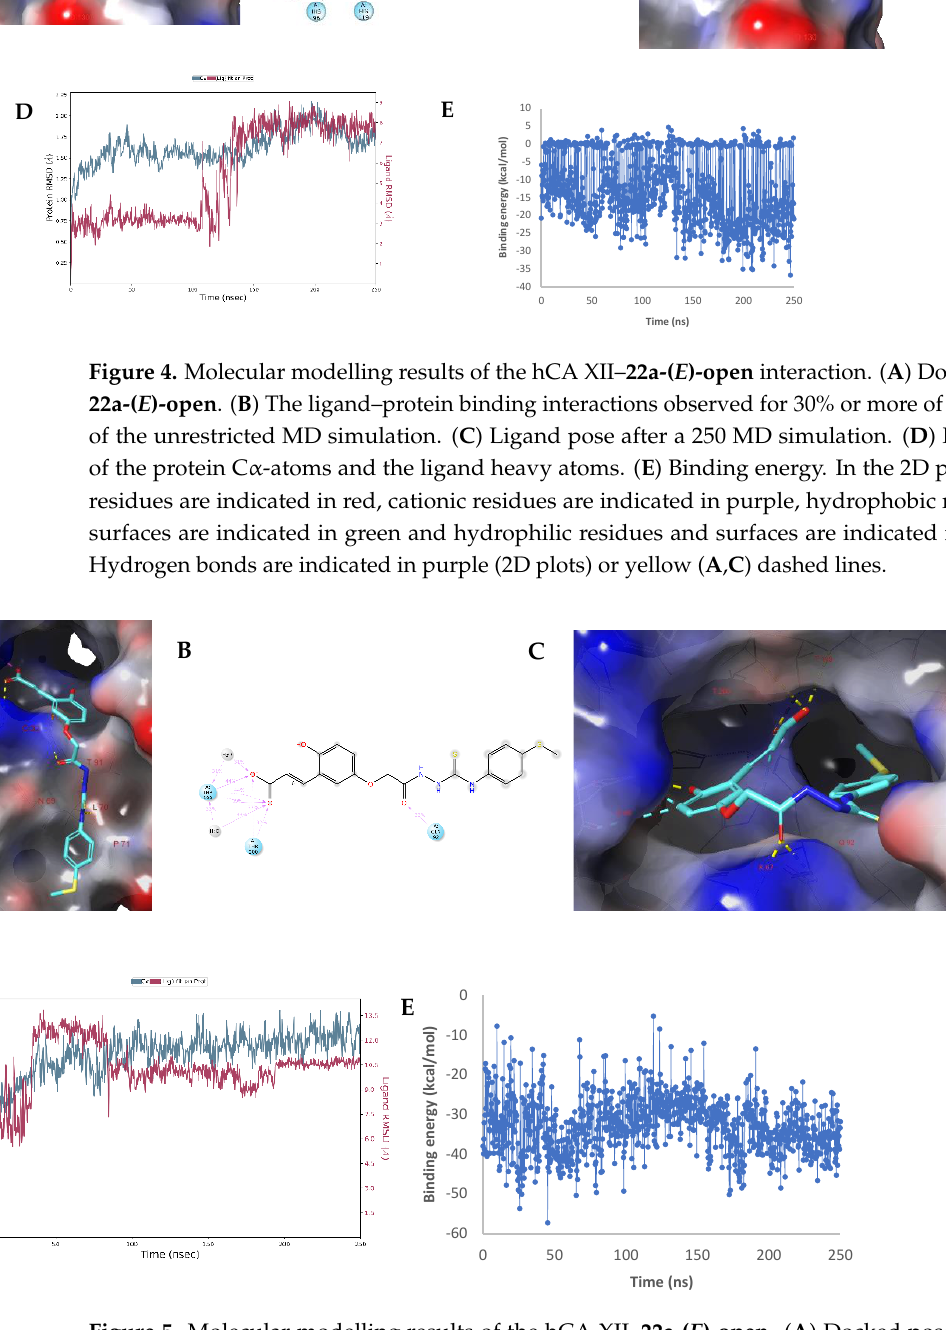
Figure 5. Molecular modelling results of the hCA XII– 22a-( E )-open . ( A ) Docked pose compound 22a-( E )-open . ( B ) Ligand–protein binding interactions observed for 30% or more of the duration of the unrestricted MD simulation. ( C ) Ligand pose after a 250 MD simulation. ( D ) RMSD value of the protein Cα -atoms and the ligand heavy atoms. ( E ) Binding energy. In the 2D plots, anionic residues are indicated in red, cationic residues are indicated in purple, hydrophobic residues and surfaces are indicated in green and hydrophilic residues and surfaces are indicated in light blue. Hydrogen bonds are indicated in purple (2D plots) or yellow ( A , C ) dashed lines.